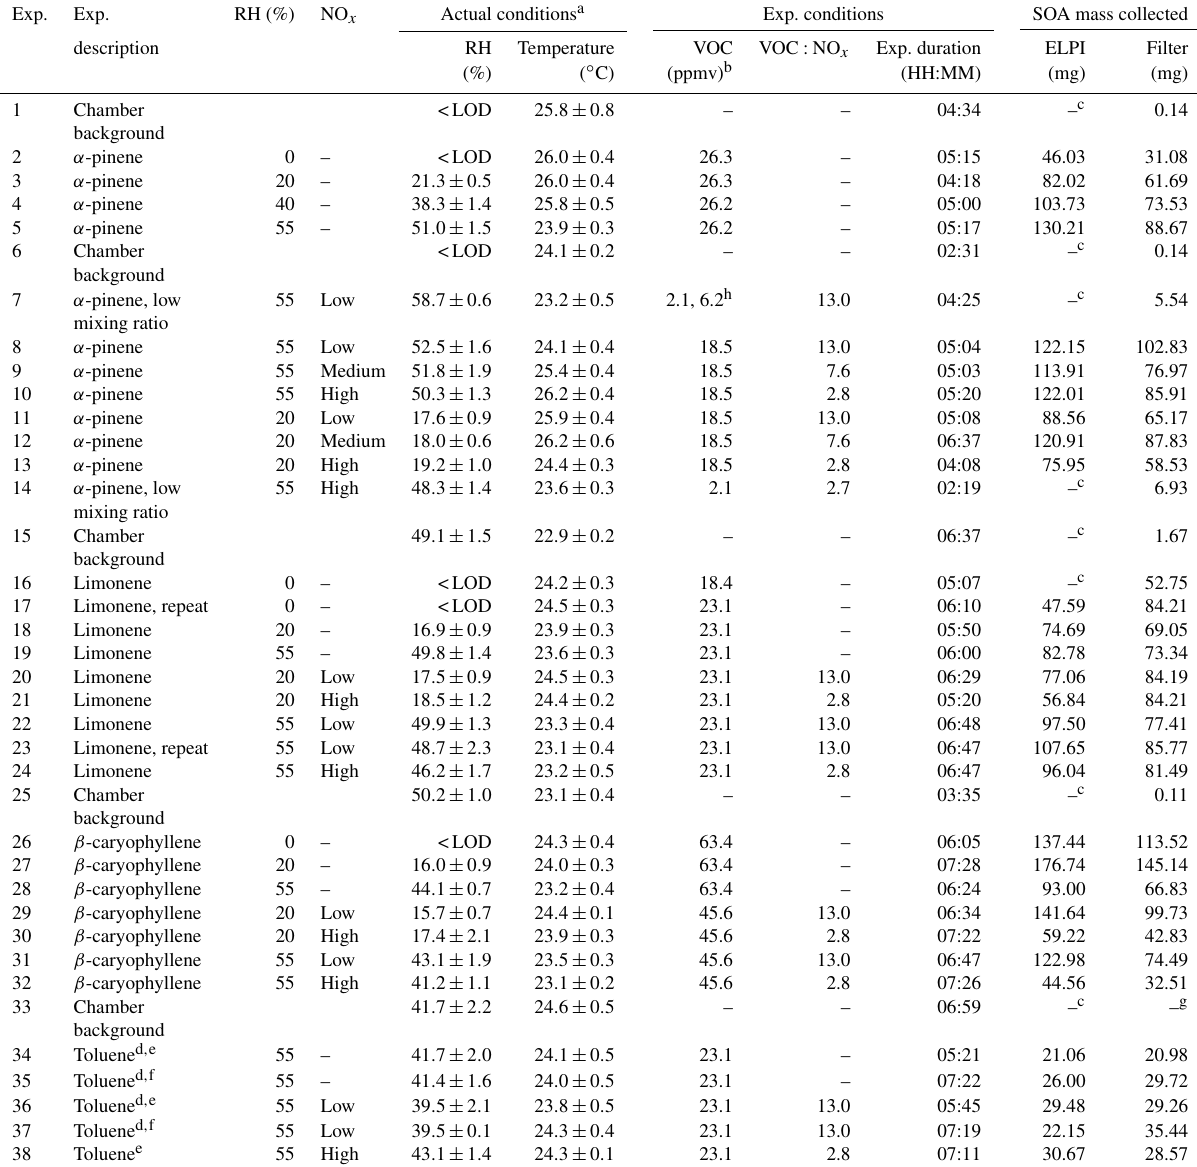
Table 1. Experimental descriptions, reactor operating conditions, VOC and oxidant mixing ratios, and amount of SOA mass collected. Exp. is an abbreviation for experiment.